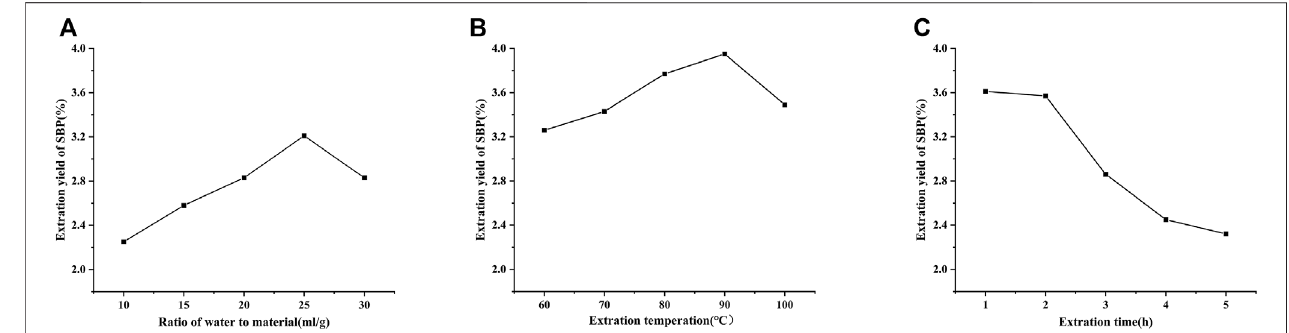
FIGURE 1 | Effects of different material-liquid ratios (A) , extraction time (B) , and extraction temperatures (C) on the SBP extraction rate.